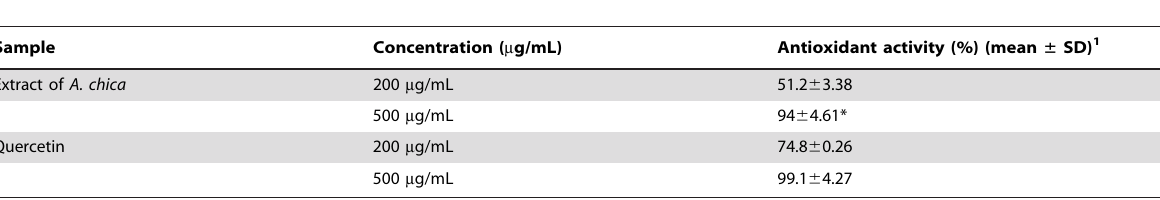
Table 6. Antioxidant activity of the extract of A. chica on b -carotene-linoleate system.